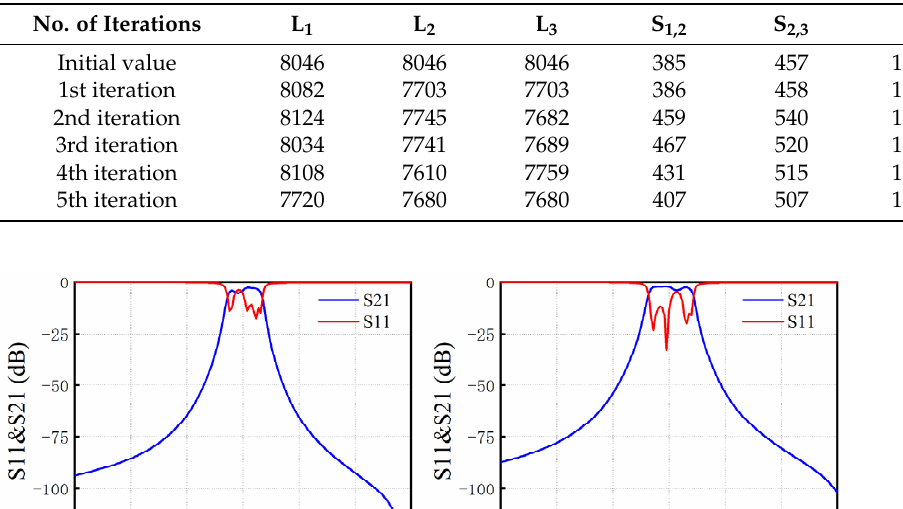
Table 1. The optimization parameter in each iteration (unit: µ m).